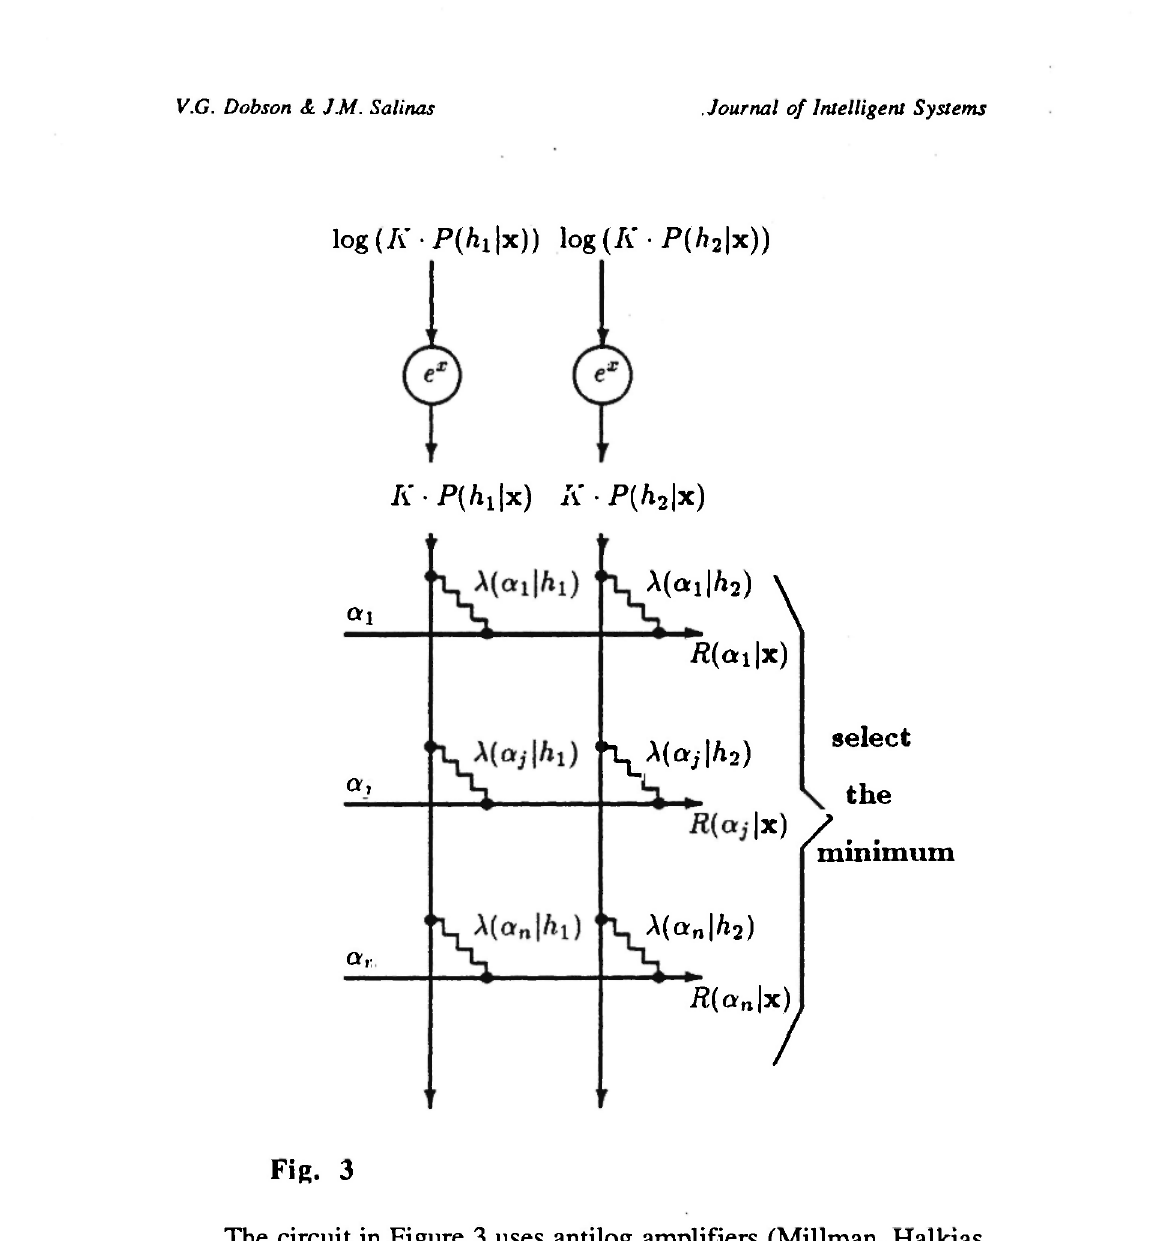
The circuit in Figure 3 uses antilog amplifiers (Millman, Halkias 1972), to convert these signals to their anti-logarithms, Κ · /'(hi Ix). These are proportional to the posteriori probabilities for each state of nature, Κ · P(hi Ix). They are then fed, via vertical conductors, into a second close-bar matrix in which the link gains are set to X(otj Ihj), and produce signals K· P(hj Ix)· λ(θ| Ihj). The horizontal conductors,